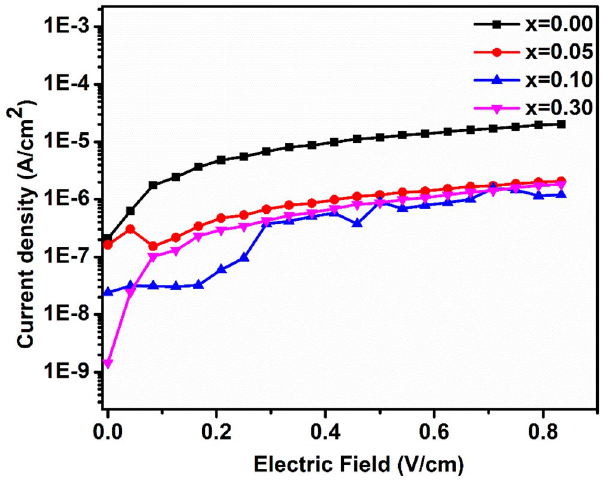
Figure 7. Leakage current density measured in (1 − x) BFO–xCFO (x = 0.00, 0.05, 0.10 and 0.30)